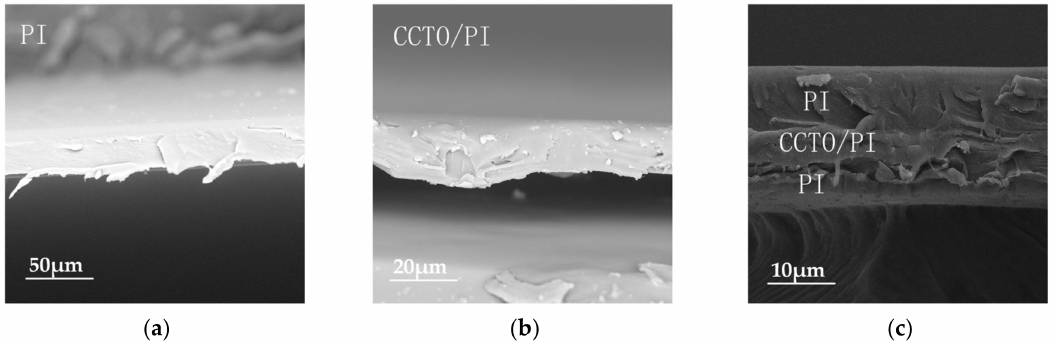
Figure 5. The cross-sectional SEM images of nanocomposite films. ( a ) The SEM image of a cross- section of a polyimide nanocomposite film. ( b ) The SEM image of a cross-section of a CCTO/PI nanocomposite film. ( c ) The SEM image of the cross-section of a PI-(CCTO/PI)-PI nanocomposite film.